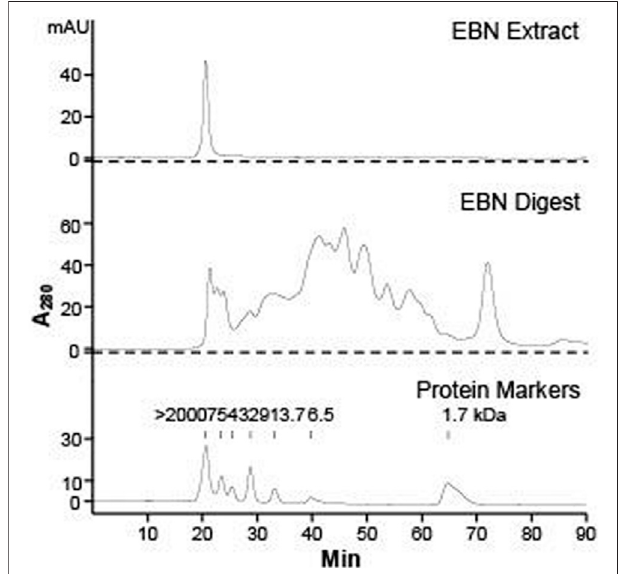
FIGURE 1 | HPLC chromatogram of EBN extract and digest. Gel chromatographic separations of Malaysia white house EBN extract (10 mg/mL, injection volume (cid:2) 10 μ L) and digest (10 mg/mL, injection volume (cid:2) 100 μ L) under UV wavelength of 280 nm are shown. The molecular weight of protein markers of α -melanocyte-stimulating hormone (1.7 kDa), aprotonin (6.5 kDa), ribonuclease A (13.7 kDa), carbonic anhydrase (29 kDa), ovalbumin (43 kDa), albumin (75 kDa), and blue dextran ( > 2000 kDa) are